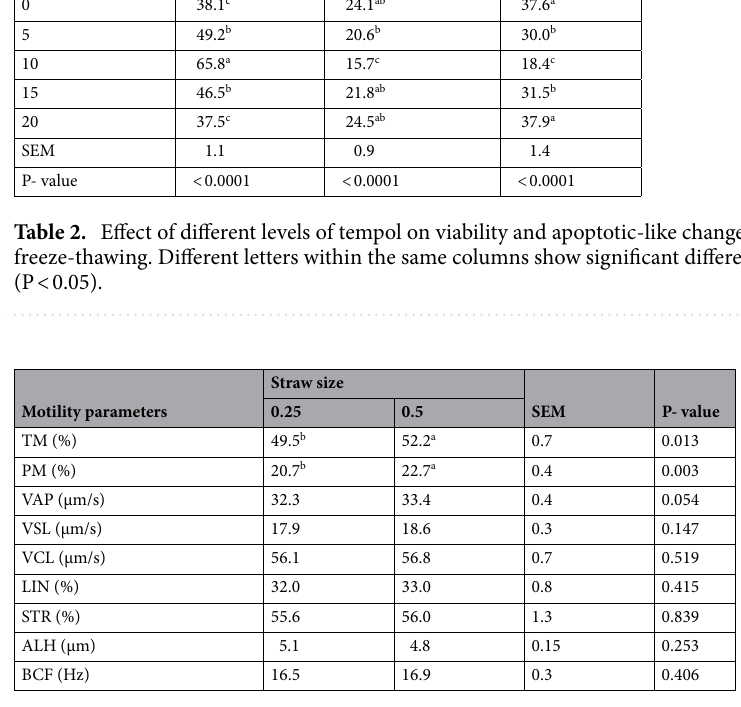
Table 3. Effect of straw size on motile parameters of rooster sperm. Different superscripts within the same row indicate differences among groups (P < 0.05). TM total motility, PM progressive motility, VSL straight– line velocity, VAP average path velocity, VCL curvilinear velocity, LIN linearity, STR straightness, ALH mean amplitude of the lateral head displacement, BCF mean of the beat cross frequency.